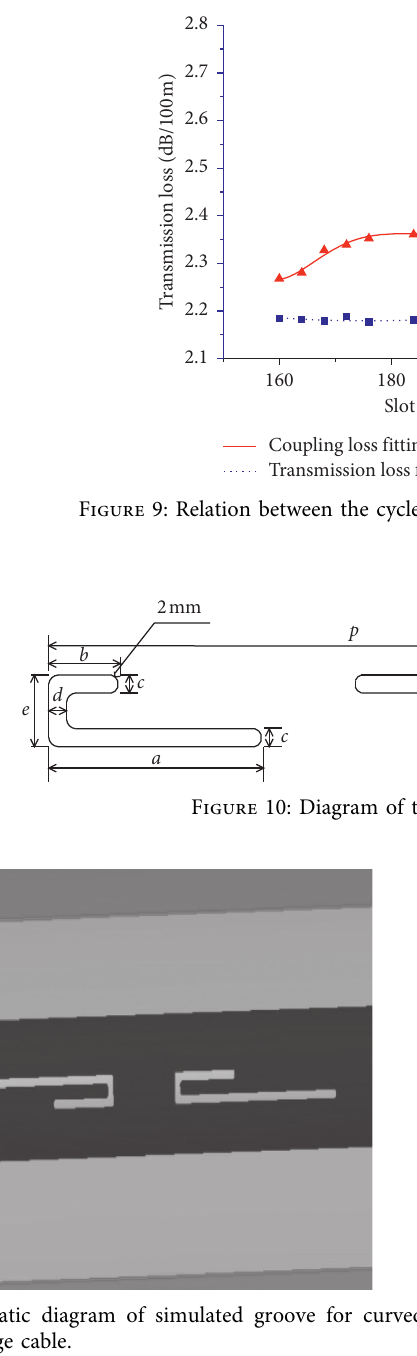
Figure 12: Coupling loss of curved hook-groove leakage